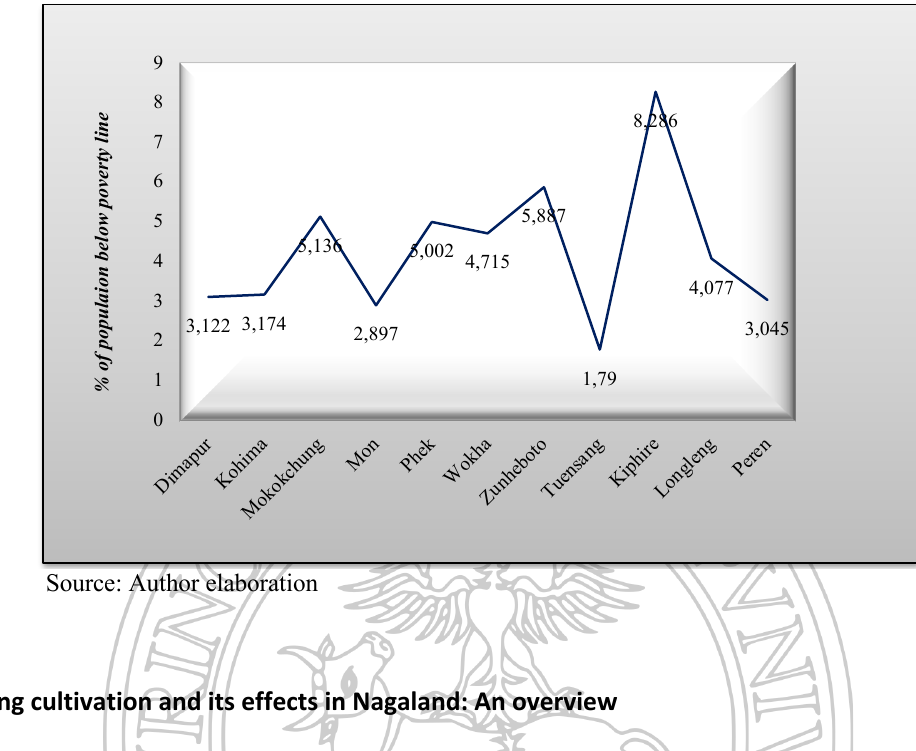
Figure 7 – Percentage of population below poverty